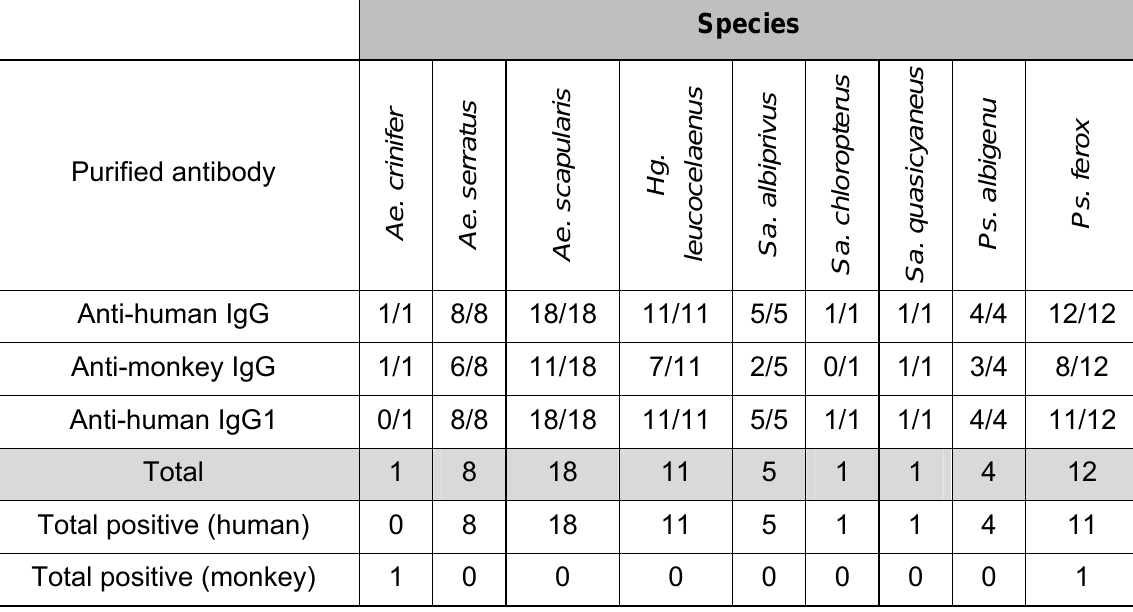
Table 2. Distribution by purified antibody (IgG) of Culicidae samples from Cachoeirinha, Garruchos, RS, collected between September 2005 and March 2007 Species